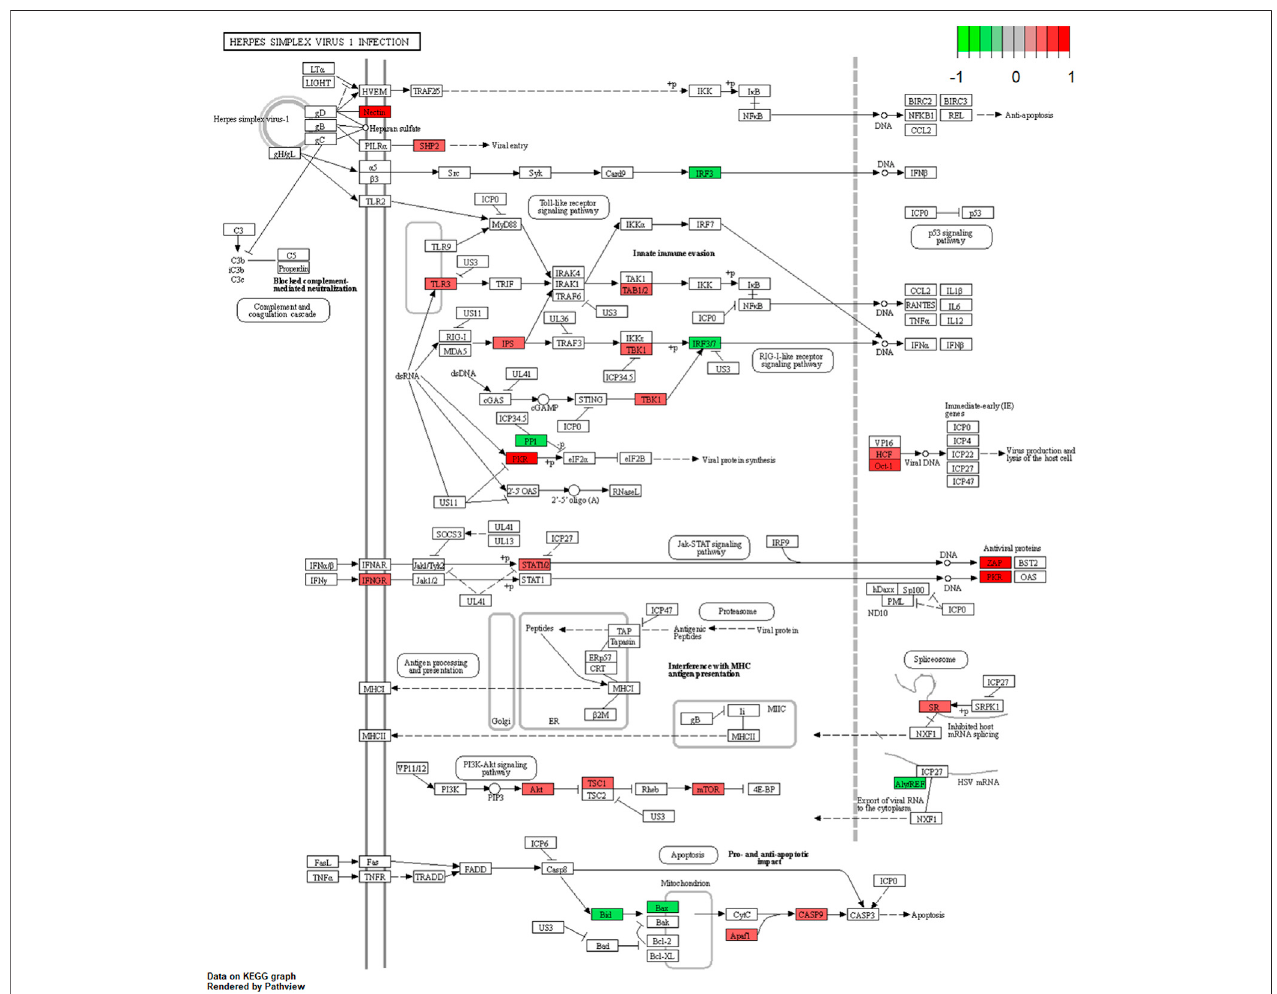
FIGURE6| Pathway ofherpes simplexvirus1infection. Note: Visualizationofapathway signi fi cantlyenriched byKEGG analysis and performed in “ pathview ” ofR software.